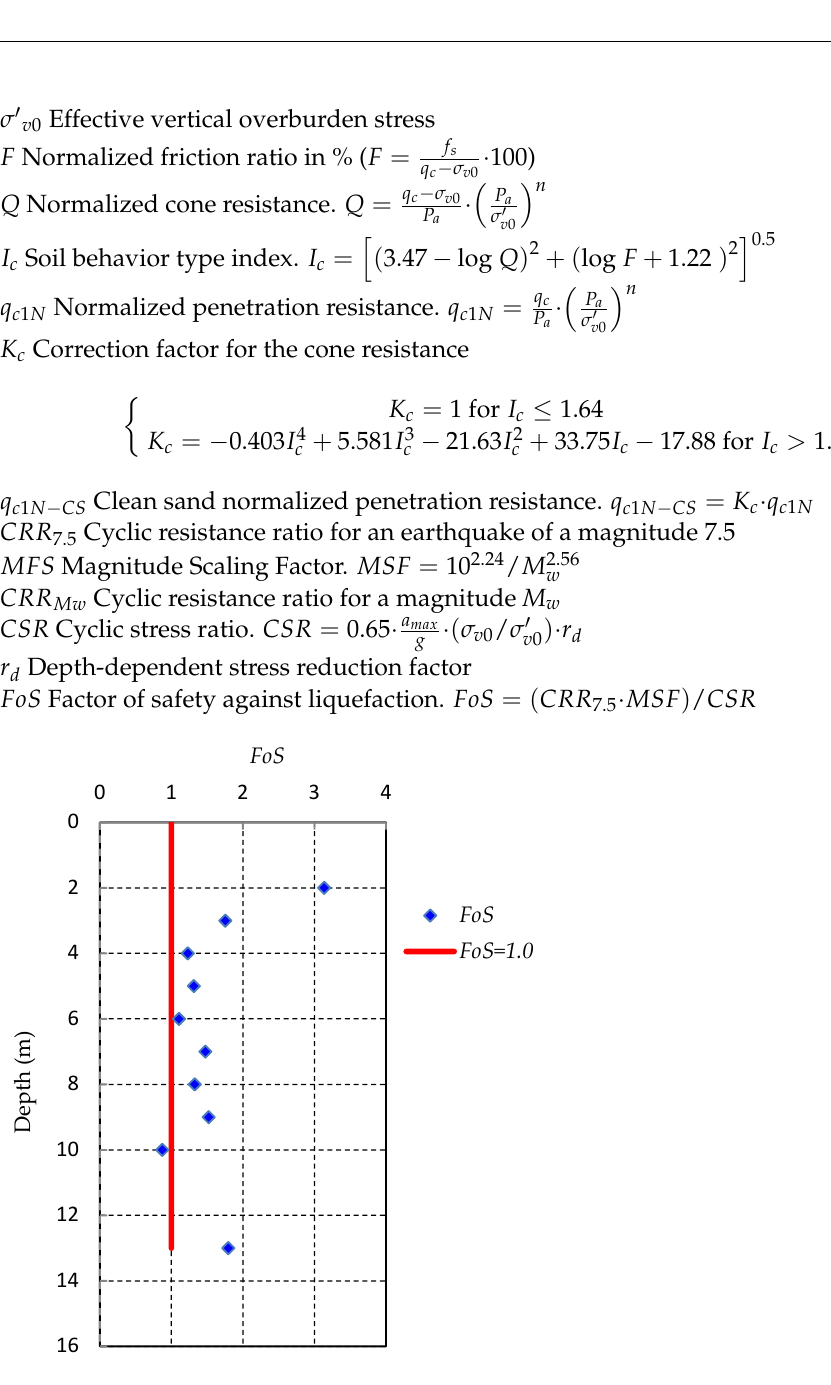
Figure 4. Factor of safety